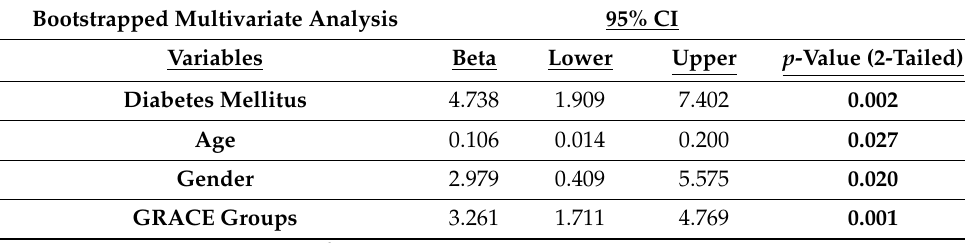
Table 2. Bootstrapped multivariate analysis for the prediction of severe coronary artery disease (SYNTAX score ≥ 33).